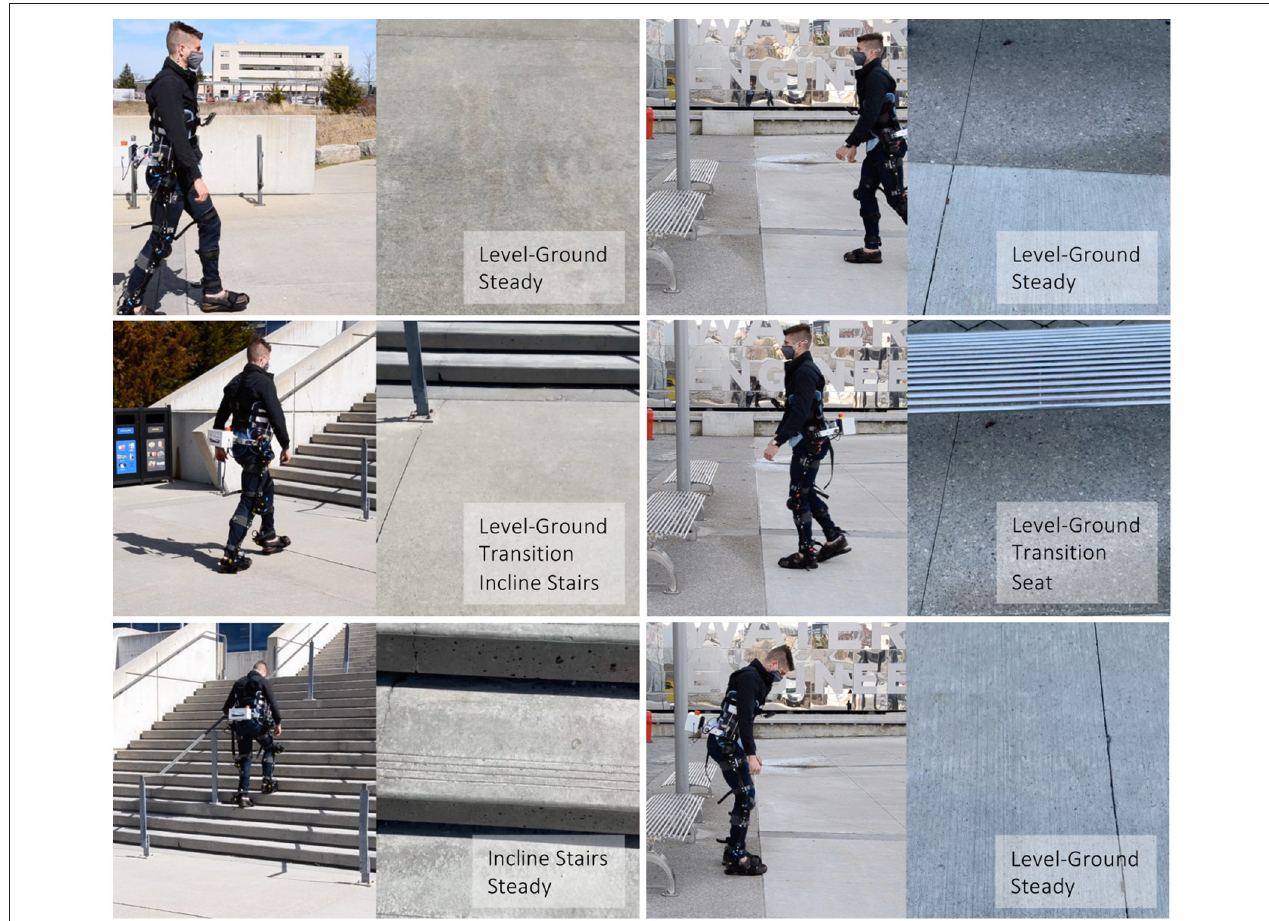
FIGURE 6 | Examples of both “steady” and “transition” states in the ExoNet hierarchical labeling architecture. The top and bottom rows are labeled as steady states and the middle row is labeled a transition state. For each column, the left images show the lead author walking with our robotic exoskeleton and the right images show the concurrent field-of-view of the wearable camera system (i.e., what the exoskeleton sees).